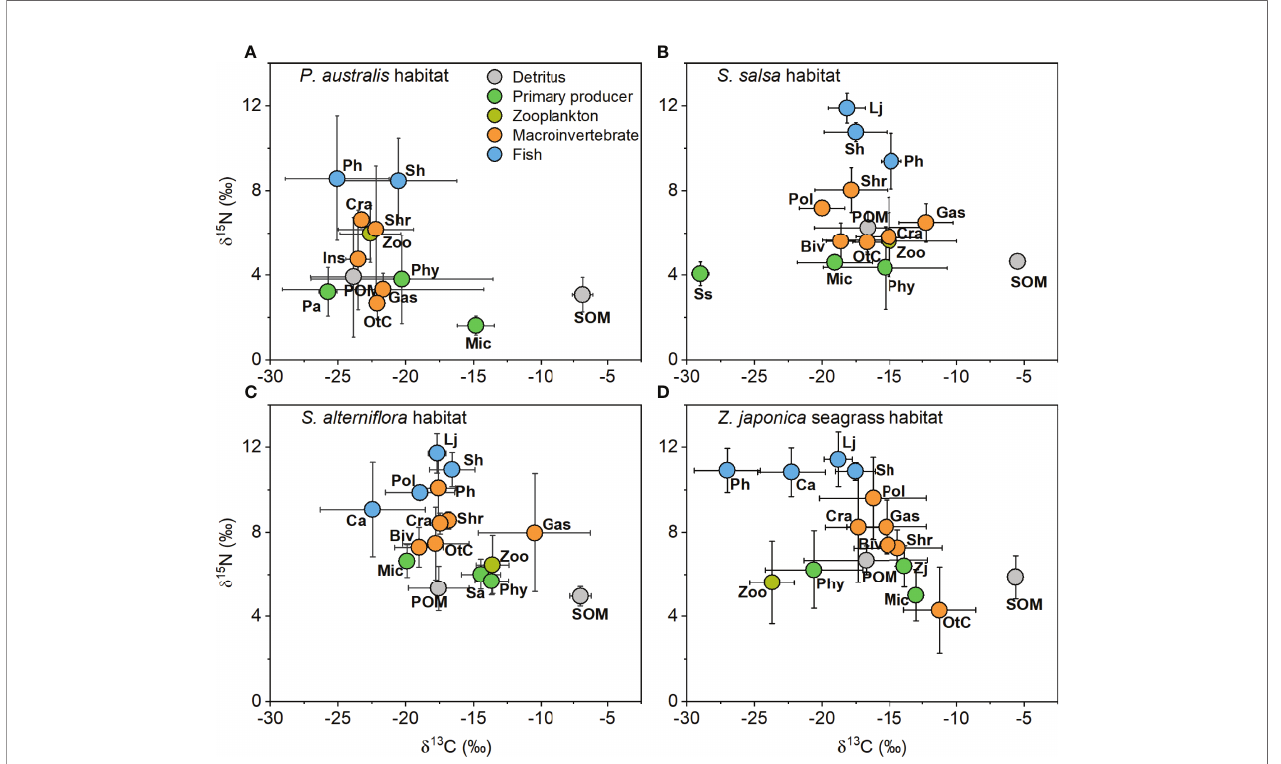
FIGURE 2 | d 13 C and d 15 N values (mean ± SD) of trophic groups collected from (A) Phragmites australis , (B) Suaeda salsa , (C) Spartina alterni fl ora , and (D) Zostera japonica seagrass habitats along the coastal topographic gradient in the Yellow River Delta. Abbreviations for the trophic groups: Biv, bivalves; Ca, Carassius auratus ; Cra, crabs; Gas, gastropods; Ins, Insects; Lj, Lateolabrax japonicus ; Mic, microphytobenthos; OtC, other crustaceans; Pa, Phragmites australis ; Ph, Planiliza haematocheila ; Phy, phytoplankton; Pol, polychaetes; POM, particulate organic matter; Sa, Spartina alterni fl ora ; Sh, Synechogobius hasta ; Shr, shrimp; SOM, sediment organic matter, Ss, Suaeda salsa ; Zj, Zostera japonica ; Zoo,